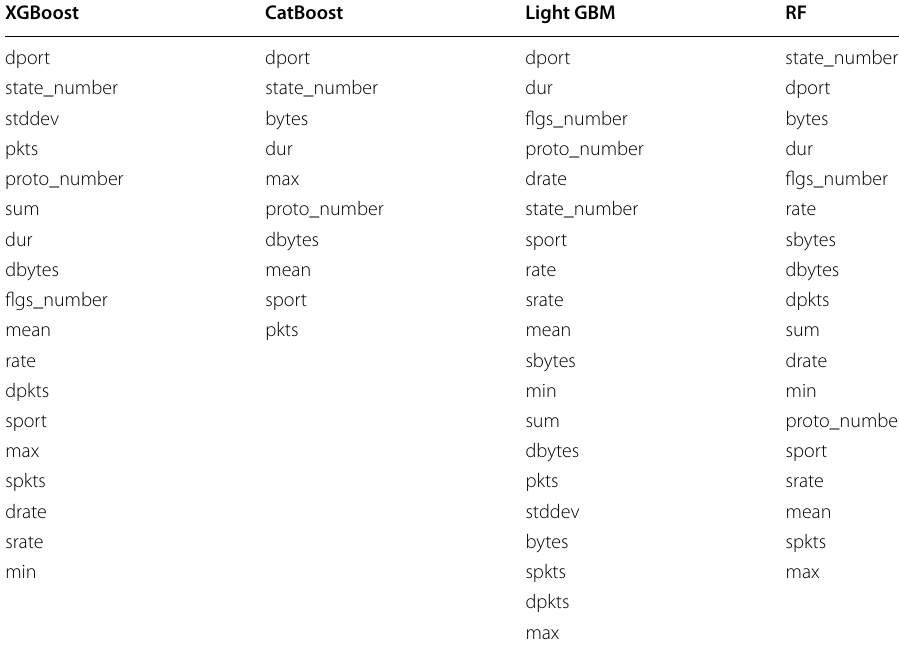
Table 55 Features by supervised ranking feature importance